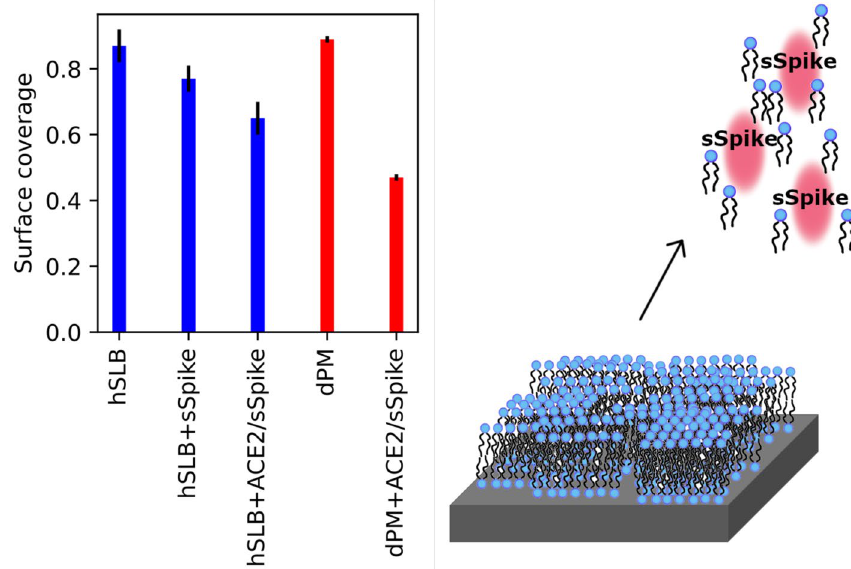
Figure 4. Bilayer surface coverage before and after the addition of sSpike to the hydrogenous synthetic SLB, i.e. hPOPC/hPOPS and the deuterated natural SLB, i.e. dPM. Schematic representation of the bilayer degradation produced by the